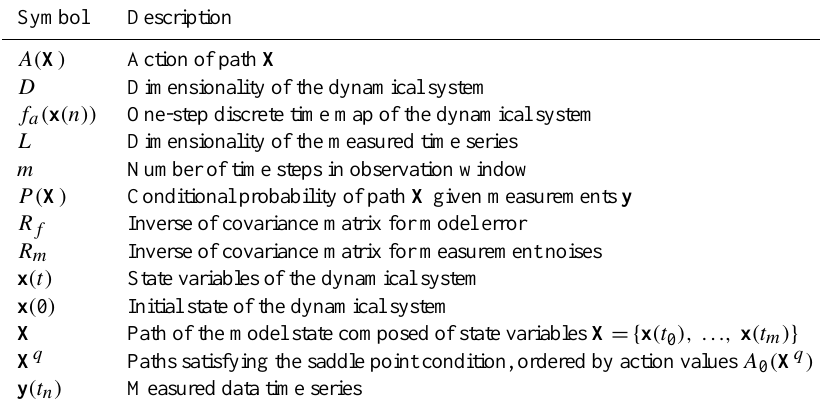
Table 2. List of important mathematical notations (in alphabetical order).